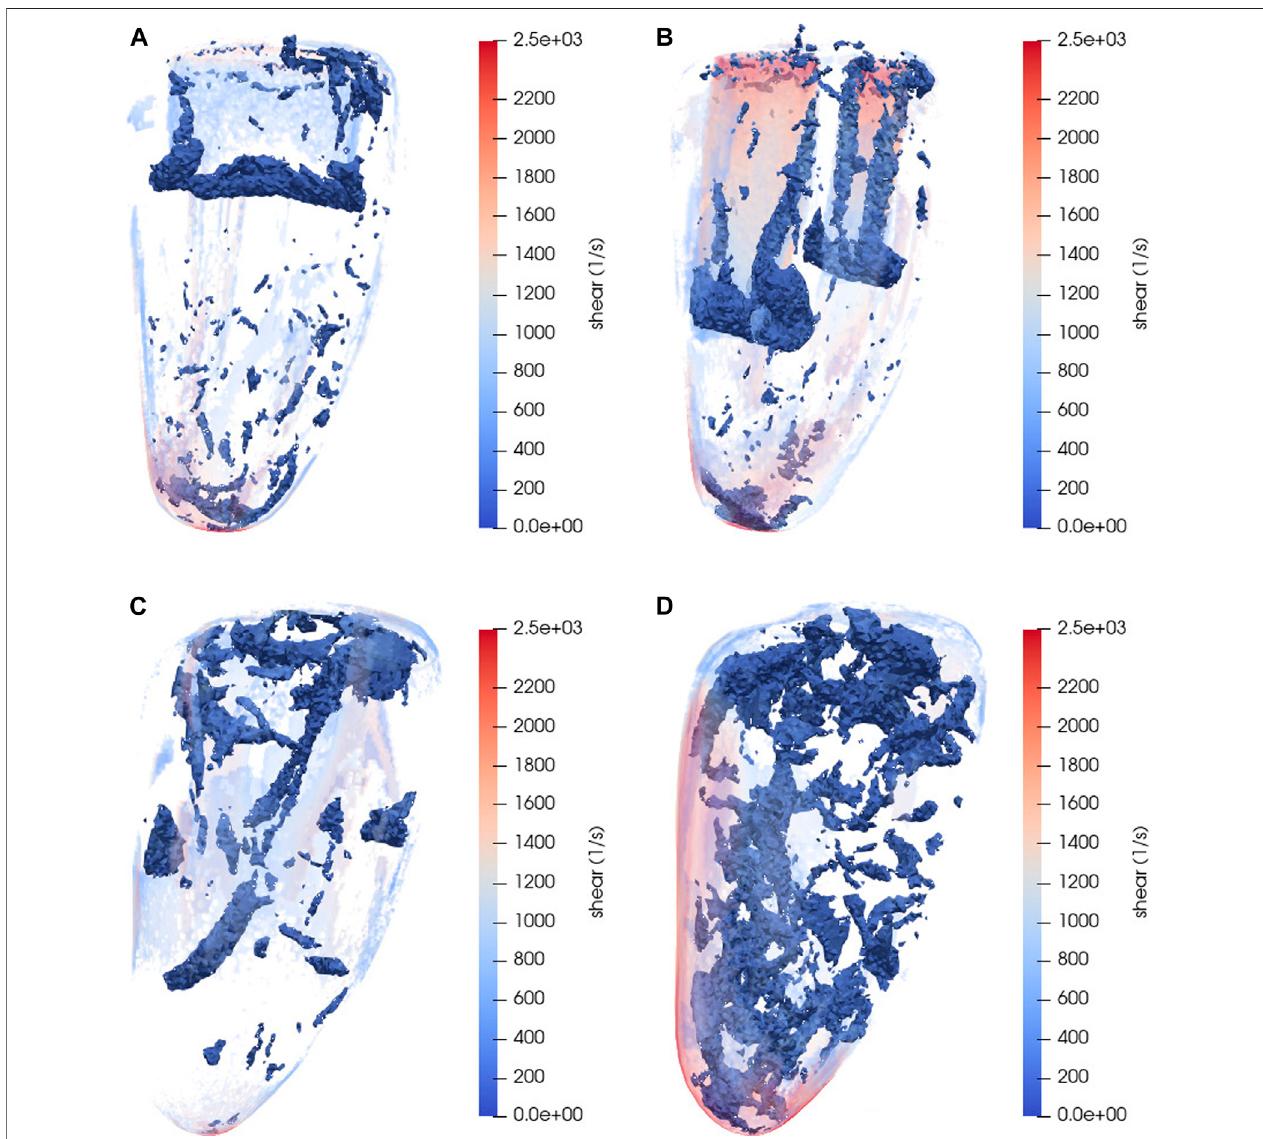
FIGURE 9 | Snapshots of 3D fl ow structures in the LV blood fl ow, as determined by the rotation magnitude. The opaque blue structures are all cells that have a rotation magnitude greater than 80 s − 1 . The transparent structures are cells with shear magnitude greater than 500 s − 1 , colored in accordance with the color bars. (A) Untreatedcase, t =0.45 s (B) MVCcase, s =0.2, t =0.45 s (C) Untreatedcase, t =0.71 s (D) MVCcase, s =0.2, t =0.71 s.Corresponding2Dsnapshotsaredisplayed in Figures 6 , 7 .